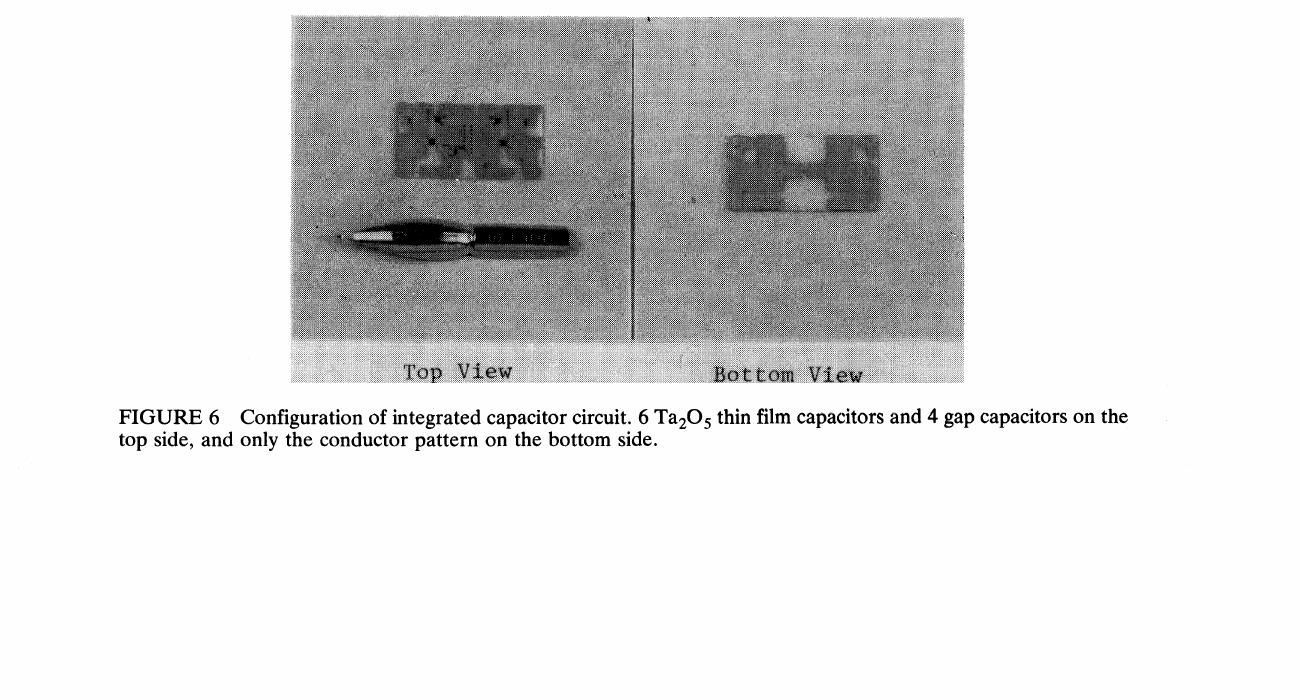
FIGURE 5 Major process steps of integrated capacitor circuit.